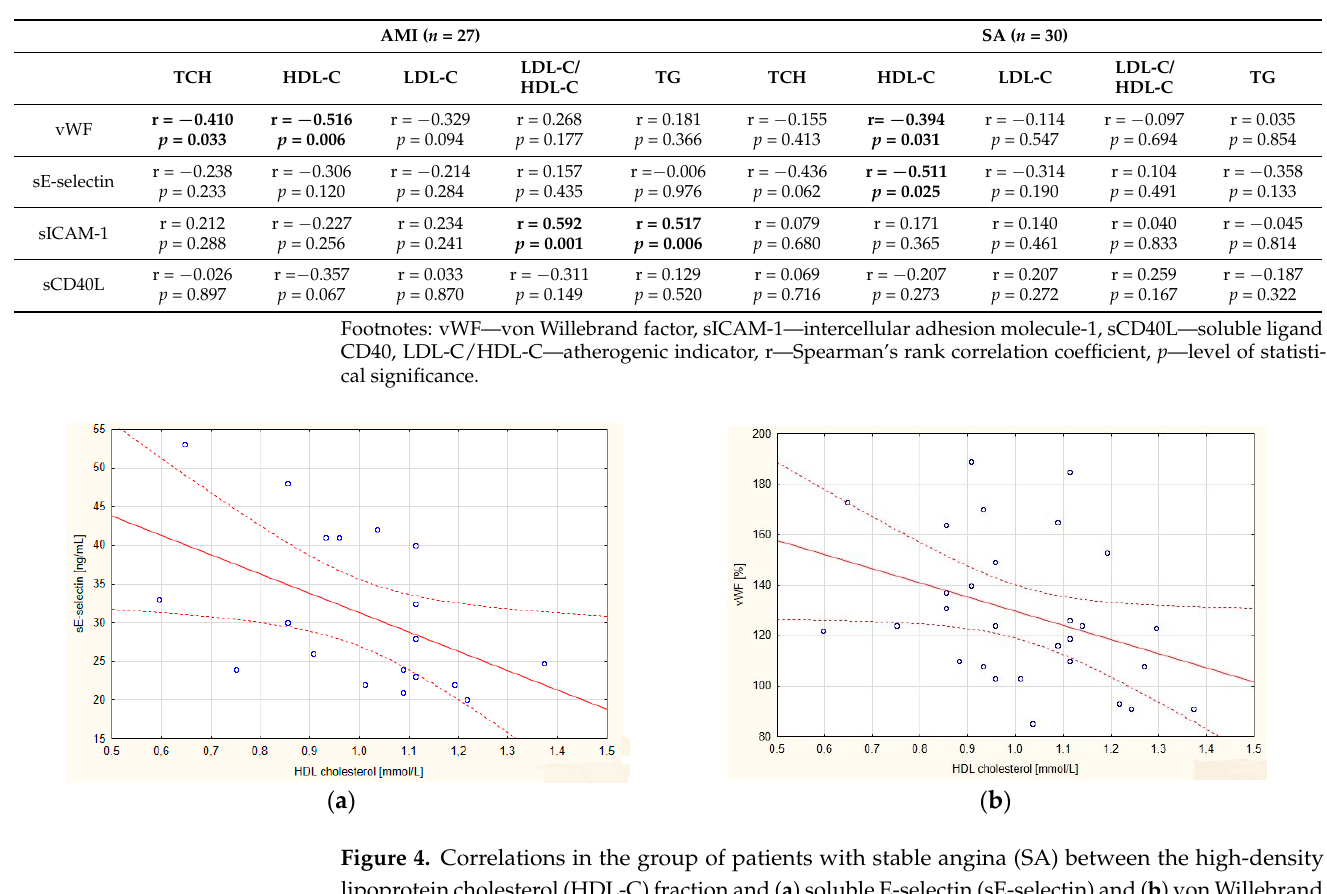
Table 4. Correlations between lipid parameters and endothelial cell markers in the patients with acute myocardial infarction (AMI) and stable angina (SA).